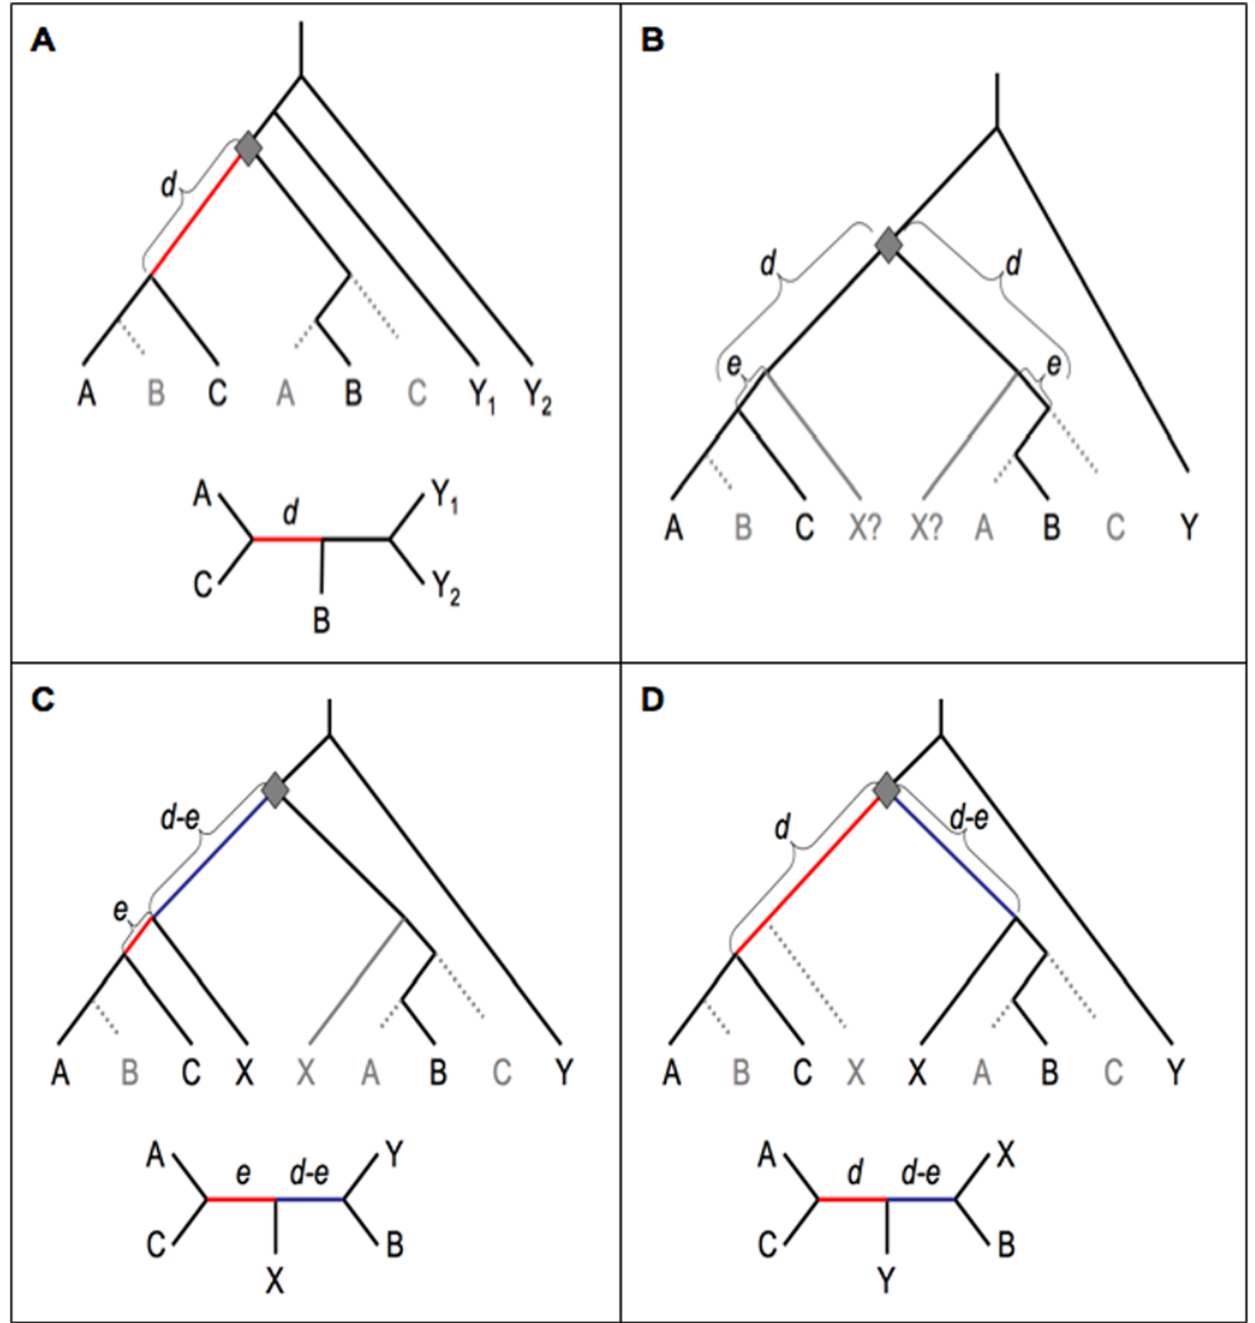
Figure 2. Gene trees with two outgroups, including at least one pre-duplication outgroup. a) Two pre-duplication outgroups Y 1 and Y 2 . b) The general case for one pre-duplication outgroup Y and one post-duplication outgroup X. c) X and C retain the same duplicate copy. d) X and B retain the same duplicate copy. Red branches indicate the NST internal branch supporting an A + C clade. Blue branches indicate the known non- species tree (KNST) branch, contradicting the known A + B + C group.